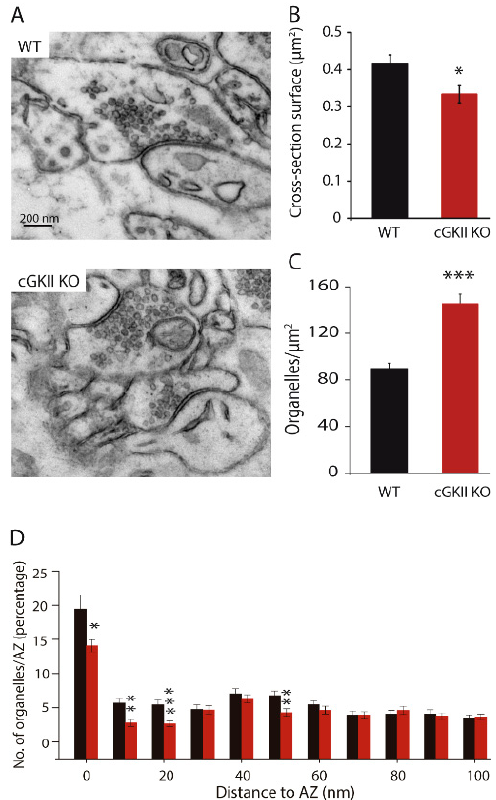
Figure 3. Morphological changes in nerve terminals from WT or cGKII KO adult cerebellum. ( A ) Electron micrographs of the cerebellar molecular layer of WT mice and cGKII KO mice. Scale bar = 200 nm; ( B ) Synapse cross-section surface expressed in µm 2 ; ( C ) Organelle density at synapses; ( D ) Percentage of vesicles located in 10 nm bins at a distance from the active zone. Data plotted in panels B–D are mean values (±SEM) from 54 WT terminals and 41 cGKII KO terminals taken from two preparations each: * p = 0.025, ** p = 0.005; *** p = 0.0001, two-tailed t -test.